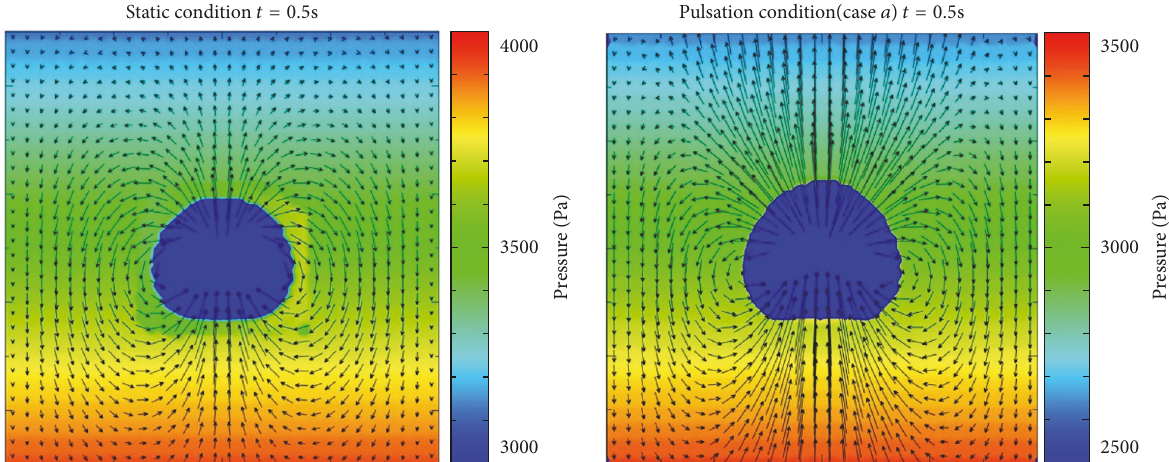
Static condition t = 0.5Ｍ